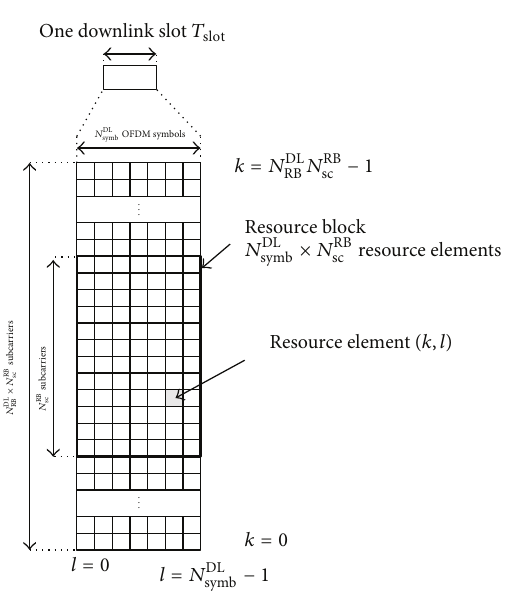
Figure 1: Frame structure type 1 [18].